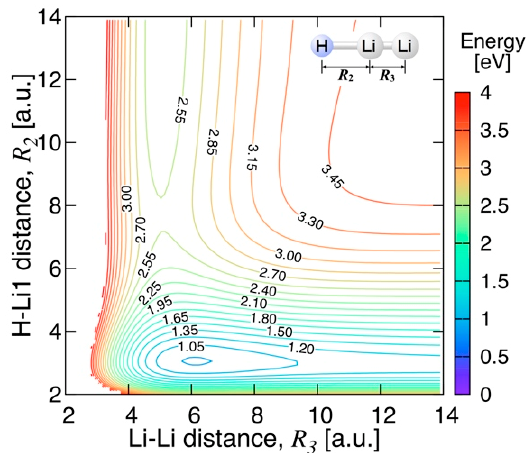
Figure 10. Energy contours for the Li − Li − H linear configuration. The energy contours are equally spaced by 0.15 eV, starting at the ground state minimum.